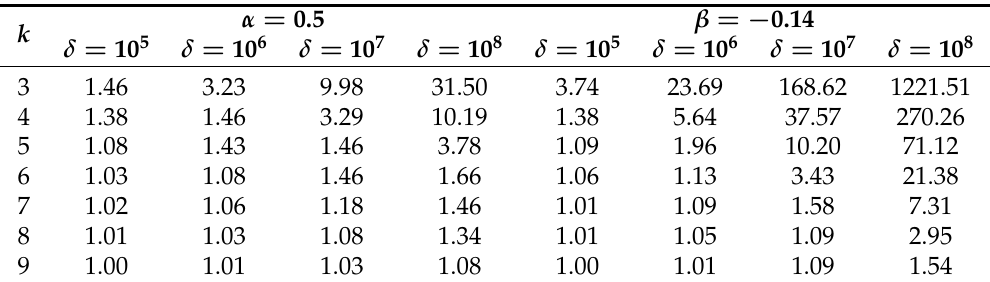
Table 1. Computed estimates of